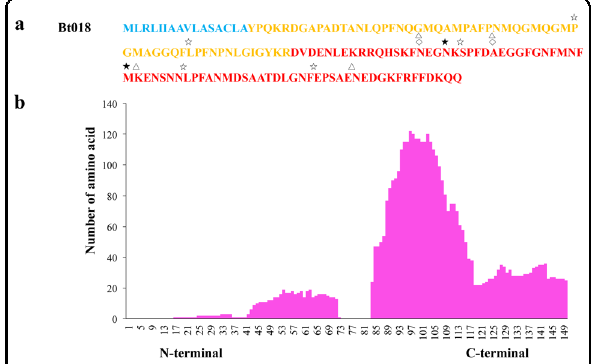
Fig. 6 Protein sequence and mapping graph of the representative conopeptide Bt018. a Protein sequence of the Bt018. Blue marks the signal peptide region, and amino acid sequences with bold font depict those peptides that were identi fi ed by MS. Amino acid sequences with open star, fi lled star, open triangle, open diamond on the top illustrate amino acid Hydroxy (P), Hydroxy (K), Gamma-carboxy-glutamic (E), and Pyroglutamic (E) modi fi cations (identi fi ed by MS), respectively. b The mapping graph was generated by the PepEx. Height of each column represents the number of amino acids for the 225 corresponding